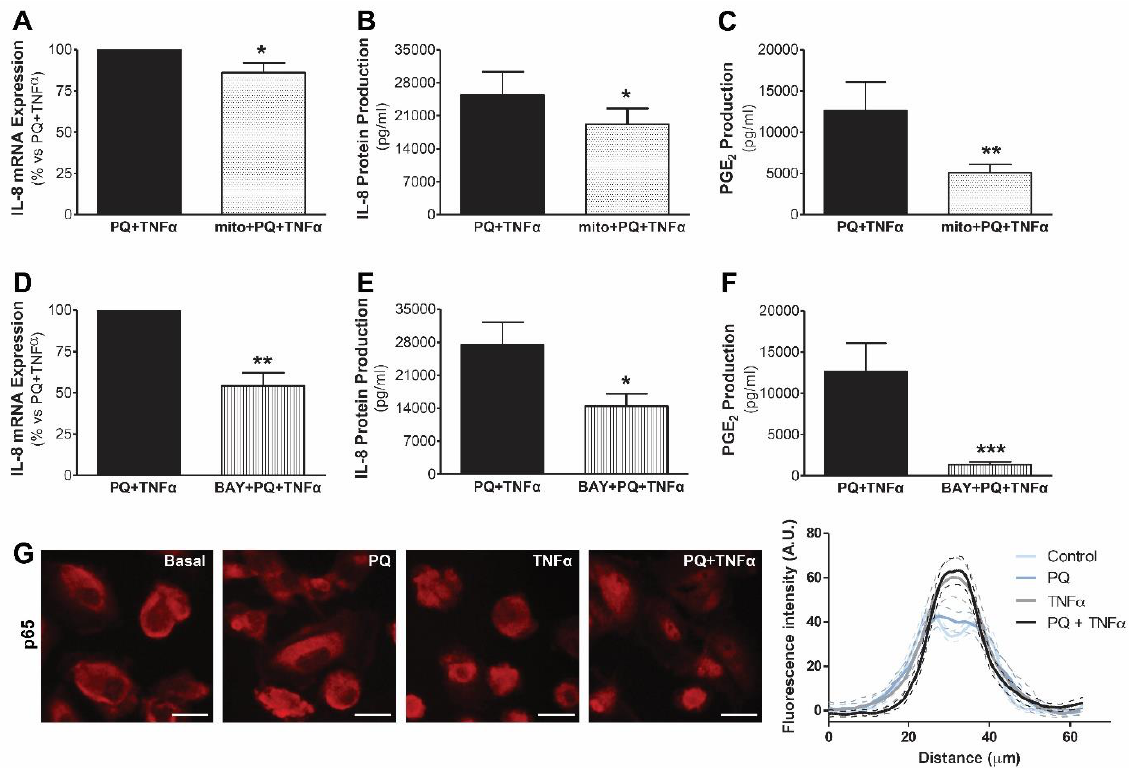
Figure 4. Role of mtROS and NF- κ B in the inflammatory response induced by mitochondrial dysfunction in human mesothelial cells from peritoneal effluent of PD patients. Mesothelial cells with epithelial phenotype were preincubated with mitoTEMPO (mito, 10 µ M) or BAY 11-7082 (BAY, 10 µ M) for 30 min before the treatment with the selective mitochondrial respiratory chain inhibitor paraquat (PQ; 1 mM) and for 30 min plus TNF α (1 ng/mL) for 18 h. ( A , D ) IL-8 mRNA expression is expressed as the mean ± SEM fold change vs. control without mitoTEMPO or BAY (n = 13 and n = 5, respectively). ( B , E ) IL-8 protein production is expressed as the mean ± SEM pg/mL (n = 21 and n = 14, respectively). ( C , F ) PGE 2 production is expressed as the mean ± SEM pg/mL (n = 17 and n = 11, respectively). ( G ) Representative immunofluorescence of p65 under basal conditions, PQ (40 min), TNFα (20 min) and P Q + T NFα (40 min) ( n = 3). Scale bars, 25 µm. Right panel shows the fluorescence intensity plot profile, measured in transects taken through individual cells (n = 30 for each condition). The data were expressed as mean ± SEM. Representative immunofluorescence of p65 under basal conditions, PQ (40 min), TNFα (20 min) and P Q + T NFα (40 min) ( n = 3). * p ≤ 0.05, ** p ≤ 0.01 and *** p ≤ 0.001.